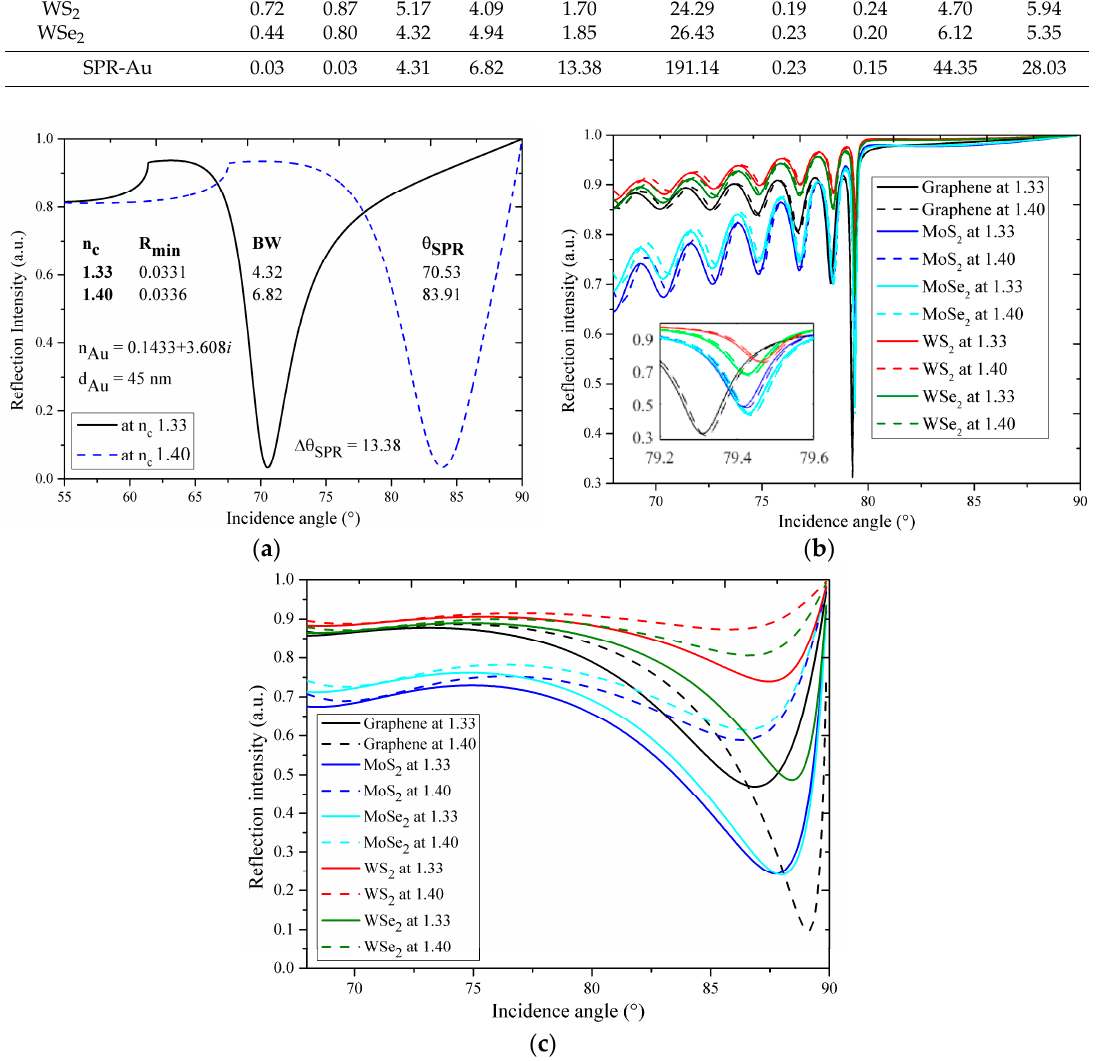
Figure 2. Reflectance curves calculated with surrounding refractive index of 1.33 and 1.40 for ( a ) Au-SPR sensor, ( b ) 1DPC with PMMA, and ( c ) 1DPC with silicon.